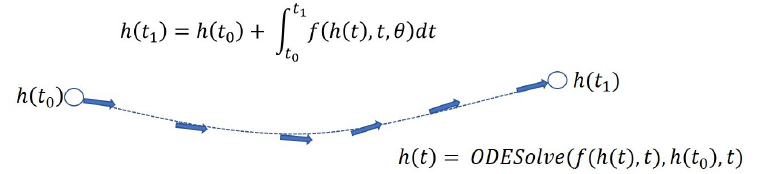
Figure 3. The latent trajectory created by forward propagation when inputting an initial value into NODE. These arrows represent the time point that is created by the adaptive mechanism of ODE solver to approach the real solution during the integration process.